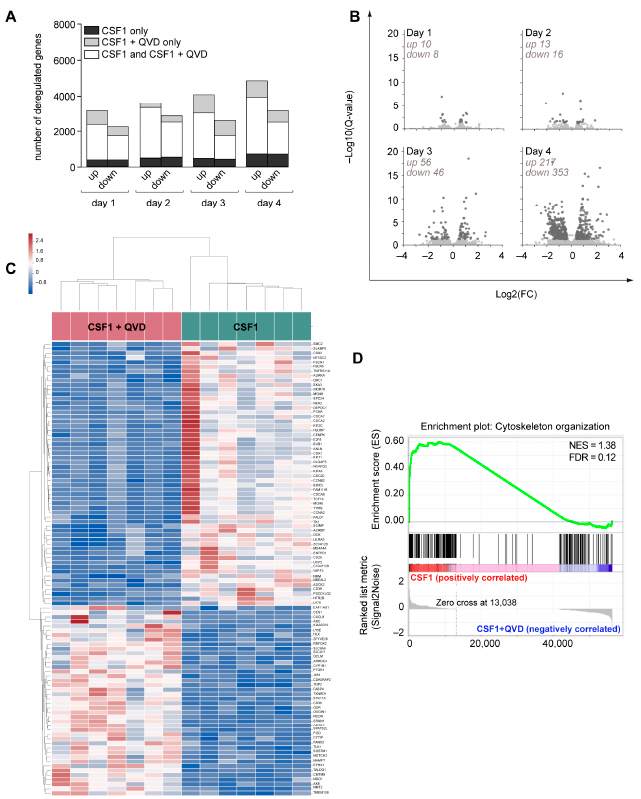
Figure 7. Impact of Q-VD-OPh on gene expression (mRNA) in CSF1-treated monocytes. Monocytes sorted from the peripheral blood of 7 healthy donors were treated by 100 ng/mL CSF1 in the absence or presence of 50 µM Q-VD-Oph (QVD) for 1, 2, 3 or 4 days. ( A ) Time dependent changes in the number of up- and down-regulated genes in CSF1-treated monocytes only (in black), in monocytes treated with CSF1 + QVD only (in gray), and in both situation (in white). ( B ) Volcano plots of differentially expressed genes in CSF1 + QVD compared to CSF1-treated monocytes (dark gray, qvalue < 0.05, fold change > 1.3). ( C ) Heatmap of the expression of the top-100 deregulated genes in monocytes treated with CSF1 alone (right) and CSF1 + QVD (left). ( D ) Gene Set Enrichment Analysis (GSEA) of CSF1 + QVD-treated monocytes compared to CSF1-treated monocytes. NES, normalized enrichment score; FDR, false discovery rate.